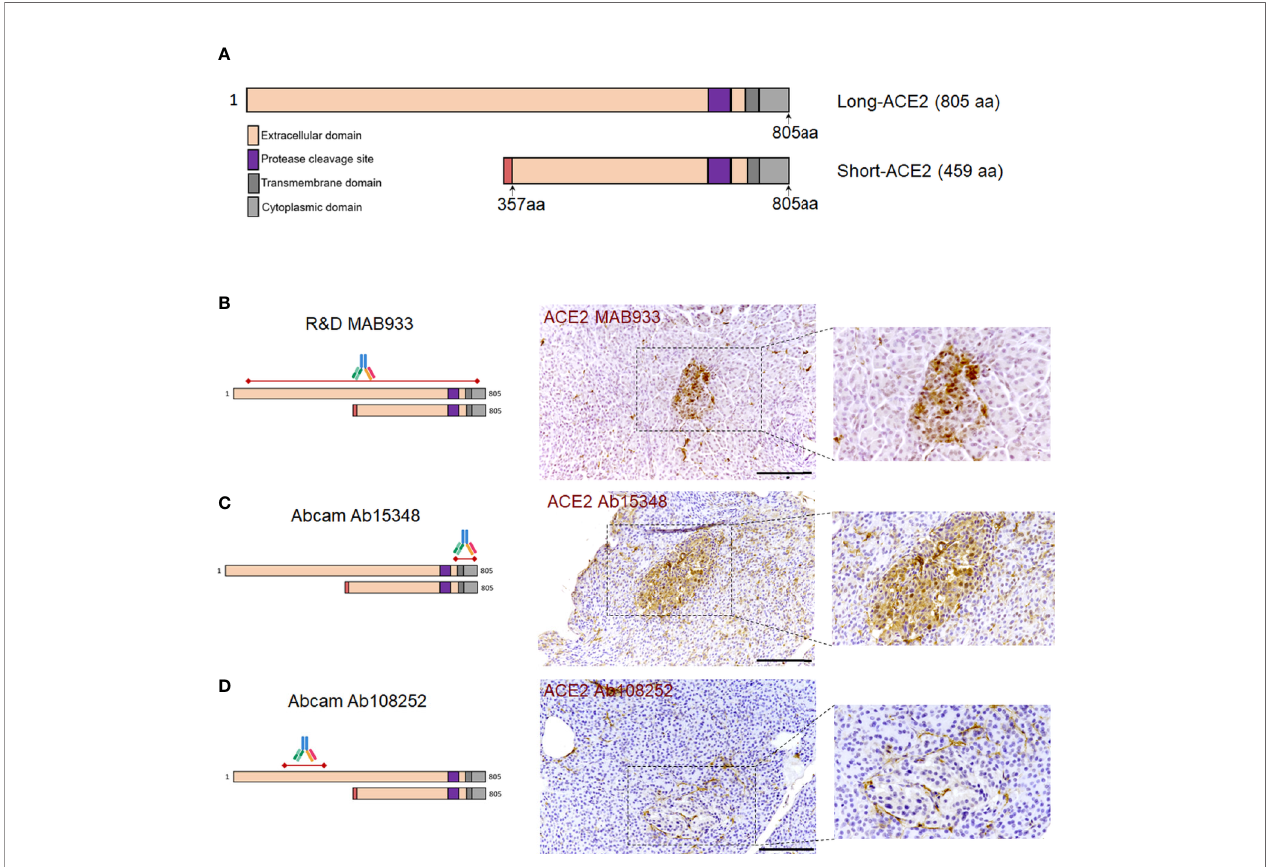
FIGURE 3 | ACE2 immunohistochemistry staining pattern in human pancreatic islets using MAB933, Ab15348, and Ab108252 antibodies. (A) Aligned sequences and structures of recently described ACE2 isoforms, long-ACE2 (805aa, ~110 kDa) and short-ACE2 (459aa, ~50kDa). Main ACE2 protein domains are reported with different colors. (B) R&D MAB933, (C) Abcam Ab15348 and (D) Ab108252 antibody predicted target sequence within the two ACE2 isoforms, alongside with immunohistochemistry staining distribution in pancreatic islets. Scale bars in (B – D) are 100 m